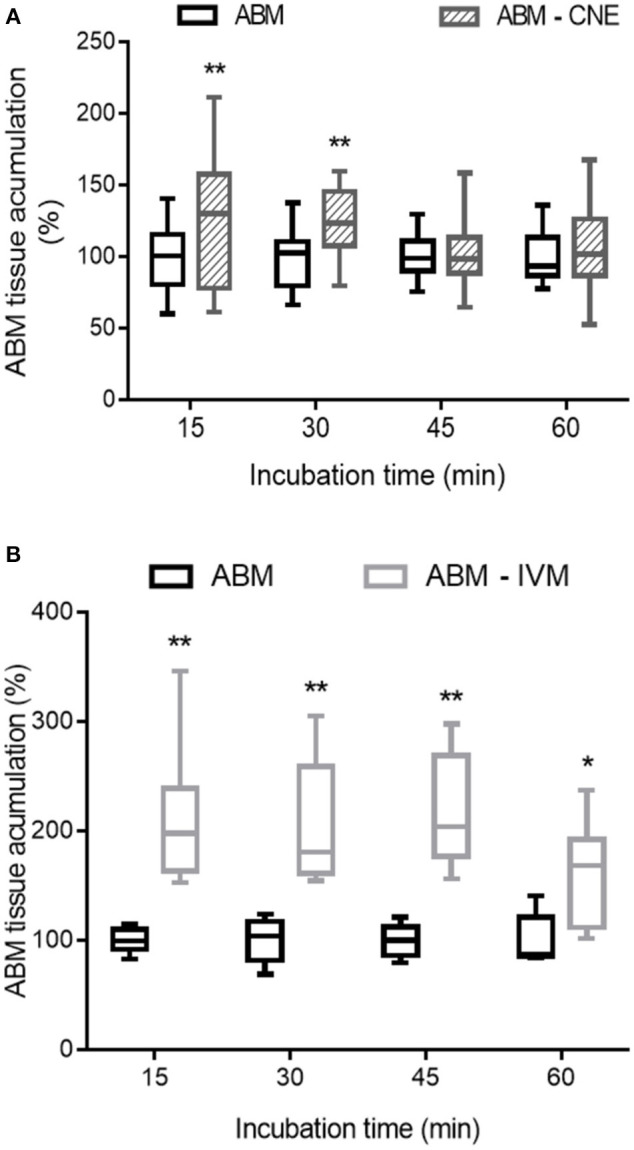
Effect of R-carvone (A, R-CNE) and ivermectin (B, IVM) on abamectin (ABM) accumulation in bovine ileal explants. Data are the mean (±SD) of 8–14 determinations and are expressed as the percentage of control group (ABM alone). Significantly different from control incubations at *p < 0.05 and **p < 0.01.